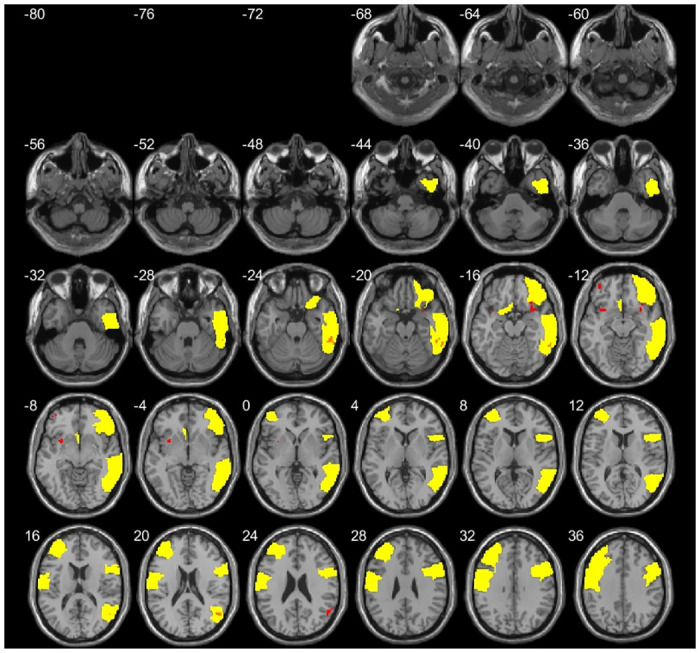
Shows the results from the AAL areas in yellow and 5 clusters from our first study [28] in red.